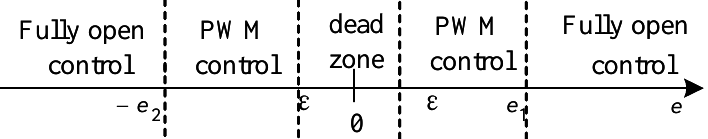
Figure 5. Traditional five-step switch control